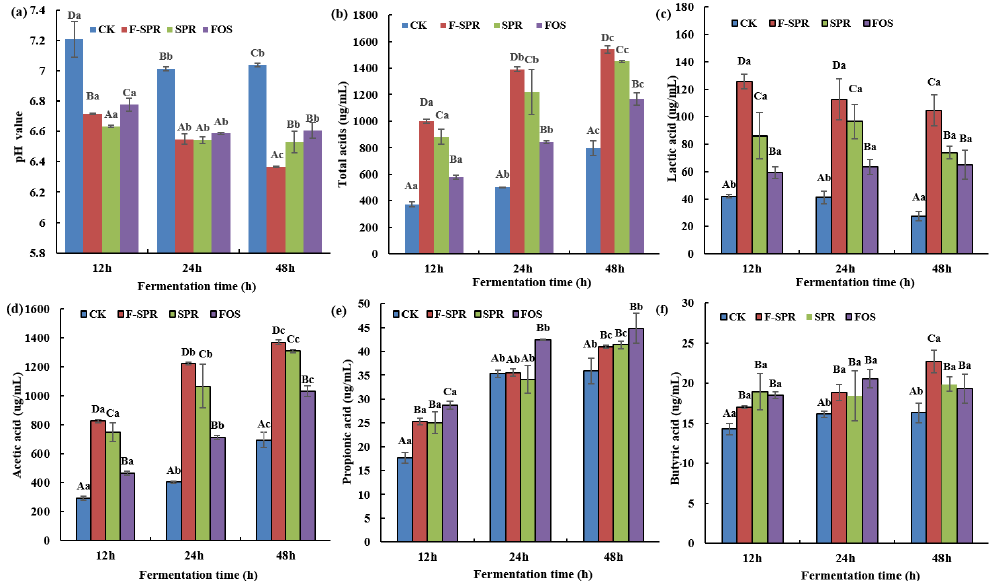
Figure 4. The pH value ( a ), total acids ( b ), lactic acid ( c ) and short chain fatty acids ( d – f ) during in vitro colonic fermentation; CK: Colonic fermentation without carbon source supplement; F-SPR: Colonic fermentation with FSPR (Sweet potato residues fermented under optimal process) supplement; SPR: Colonic fermentation with SPR (Sweet potato residues) supplement; FOS: Colonic fermentation with FOS (fructo-oligosaccharides) supplement; Uppercase letters: Significantly different ( p < 0.05) of different samples supplement at same fermentation time; Lowercase letters: Significantly different ( p < 0.05) of each sample at different fermentation